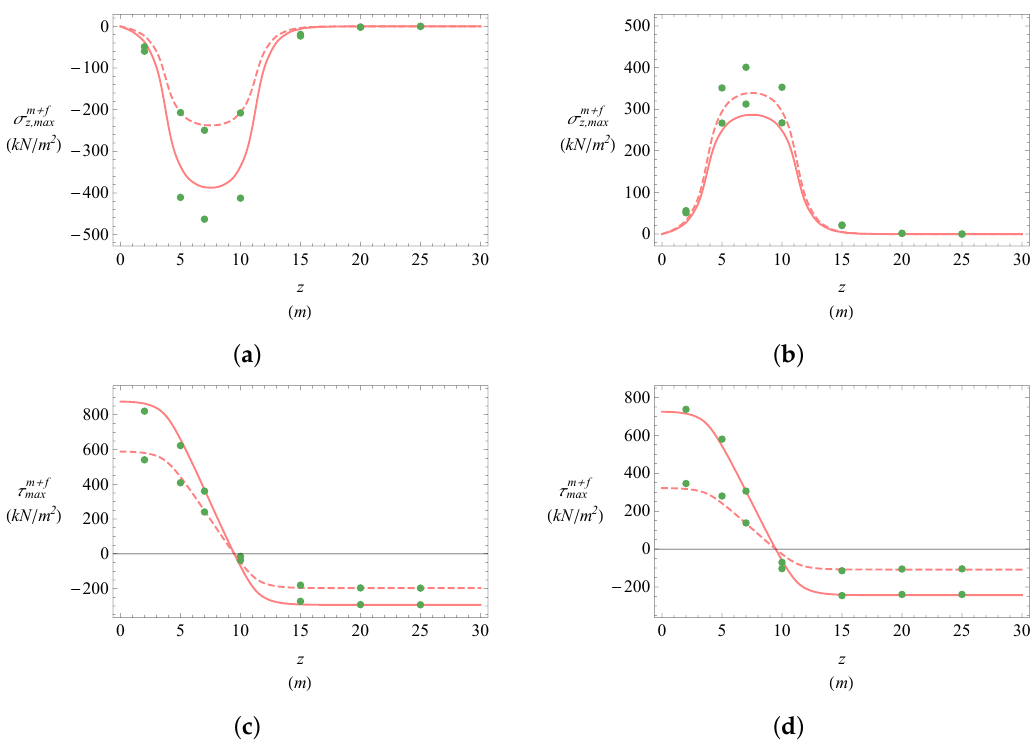
+ f = σ m + σ f z , max and tangential τ z , max : z